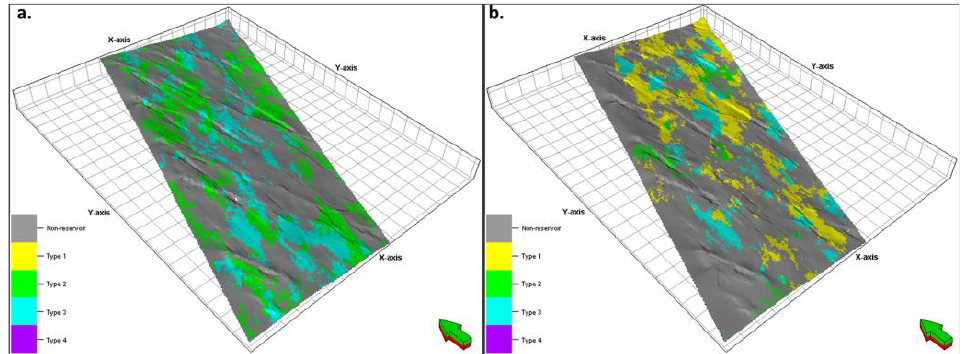
Figure 18. The rock type models of Unit 4 ( a ) and Unit 5 ( b ). Four rock types exist in the model. The rock typing criteria is in Table 3. Rock type 1 only exists in Unit 5 where the conventional gas reservoir developed, while the other three types distribute in both the conventional and the tight reservoir.